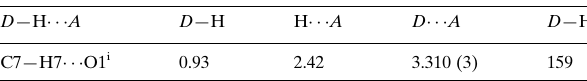
Hydrogen-bond geometry (A˚ , (cid:2)